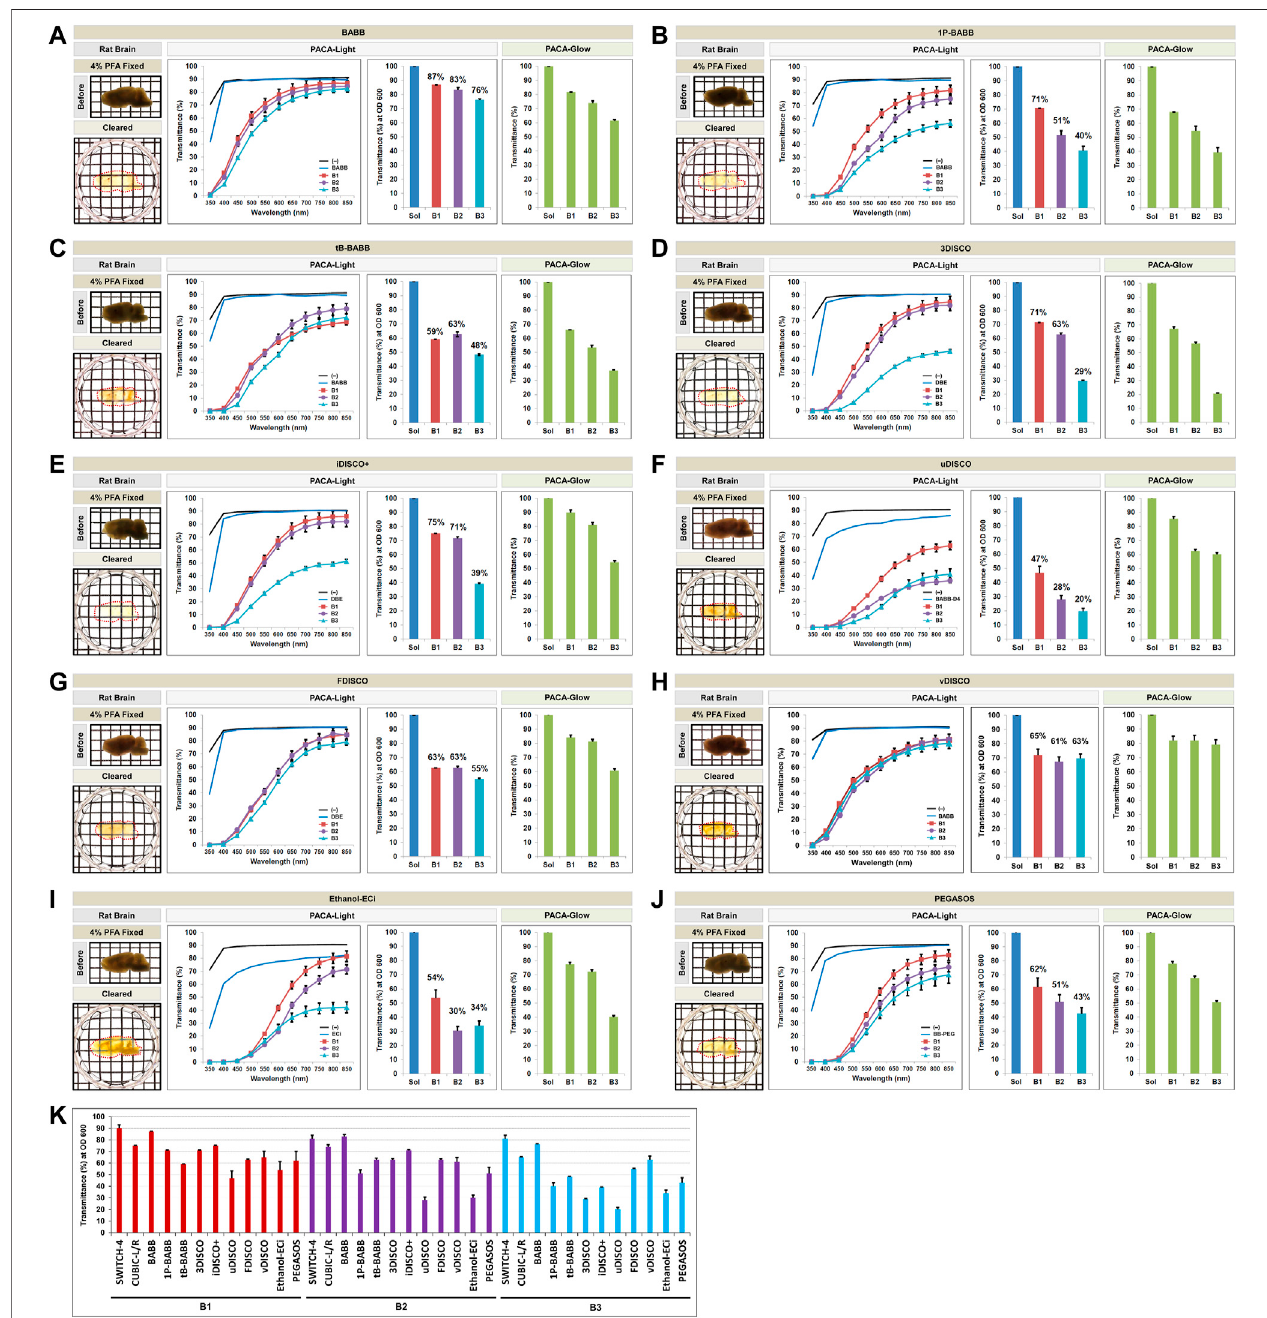
FIGURE6| Comparisonoftissueclearingachievedinratbrainsprocessedwithhydrophobictissueclearingprotocols.Comparisonofclearingef fi caciesofEthanol BABB (A) ,1-propanolBABB (B) , tert -butanolBABB (C) ,3DISCO (D) ,iDISCO+ (E) ,uDISCO (F) ,FDISCO (G) ,vDISCO (H) ,Ethanol-ECi (I) ,andPEGASOS (J) inratbrain samples (3 mm thickness) with both PACA-Light and PACA-Glow. All tissue clearing time course are shown in Supplementary Figure S9 . Optical images show samples after clearing (red dotted line), as well as any changes in sample size upon tissue processing (also Supplementary Figure S12 ). (K) Comparison of clearingef fi caciesoften hydrophobic tissueclearing protocols. Three discsfrom three distinctbrainregions(B1: prefrontal cortexand basal ganglia, B2: cerebral cortex and midbrain/diencephalon, B3: cerebellum) were generated and analyzed for each sample. Each color line and bar point to assessment values of empty (black) and refractive index matching solution (blue) of each protocol, and three distinct regions of the brain the B1 (square, red), B2 (diamond, violet), and B3 (triangle, sky blue). Green bars point to assessment values of glow light (unit) in dark. Results represent three replicates of each experiment, and data are presented as the mean ± SD (standard deviation). The transparency of the cleared brain was evident against a patterned background (length:width (cid:1) 5 mm:5 mm).